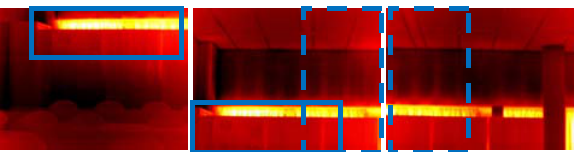
Figure 4. Example of 3 thermographies needed to cover an area. The blue rectangles show the overlapping areas